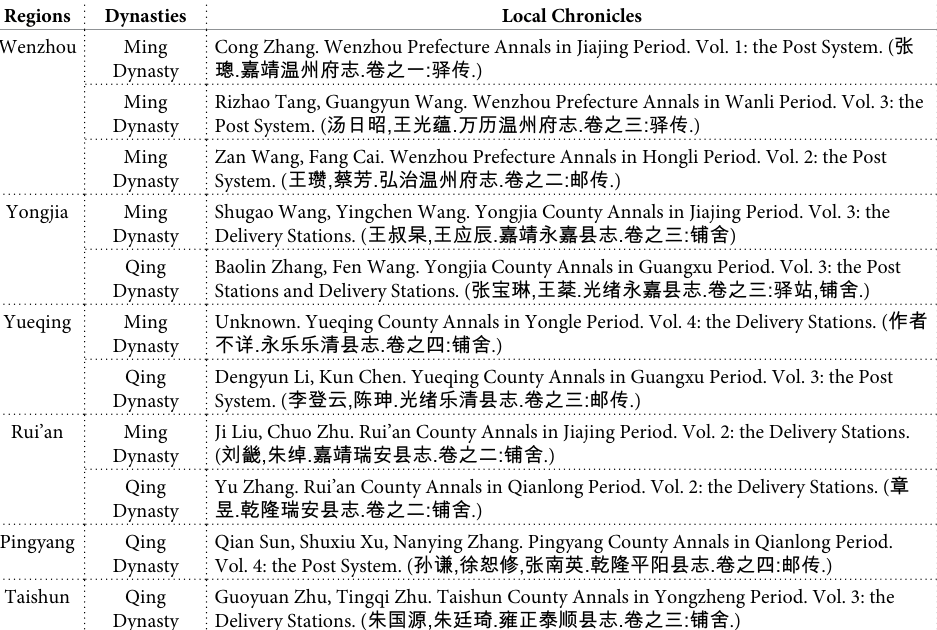
Table 1. Local chronicles